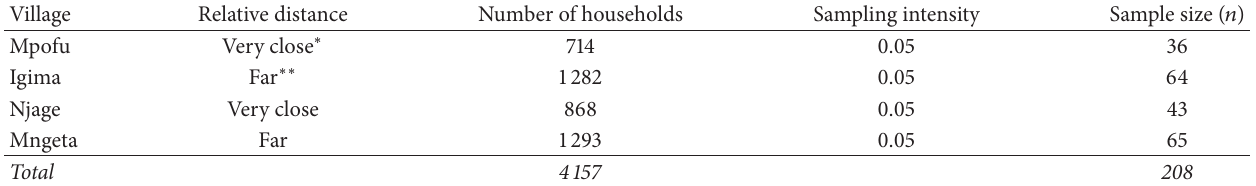
Table 2: Sample size distribution in the study